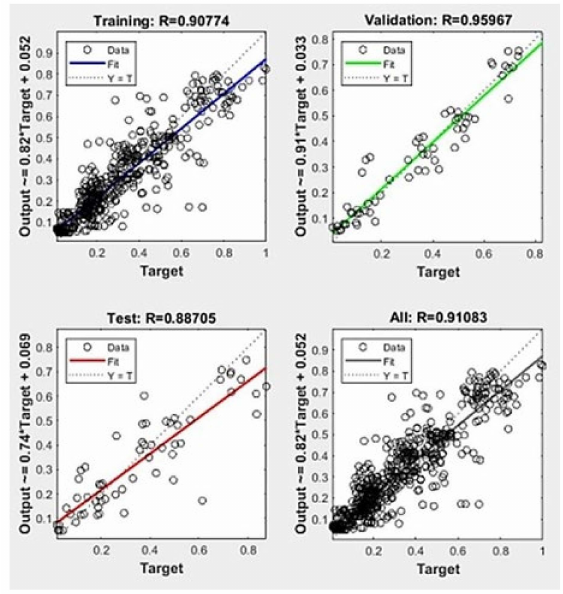
Figure 1. Correlation coefficients R for the specific sets.